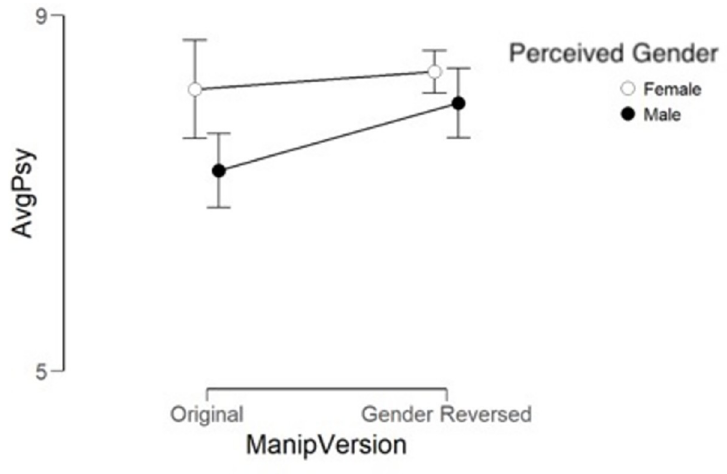
Fig 7. Comparison of ratings of original narratives and gender-reversed narratives by perceived gender and physical violence. Hollow circles stand for female and filled circles for male gender, original ratings is on the left side and gender reversed on the right side. Bars show 95% confidence